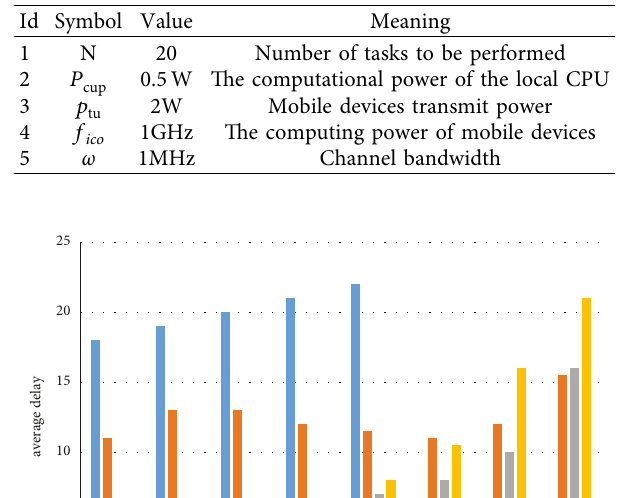
Table 1: Reference table to the relevant parameters of edge calculation.